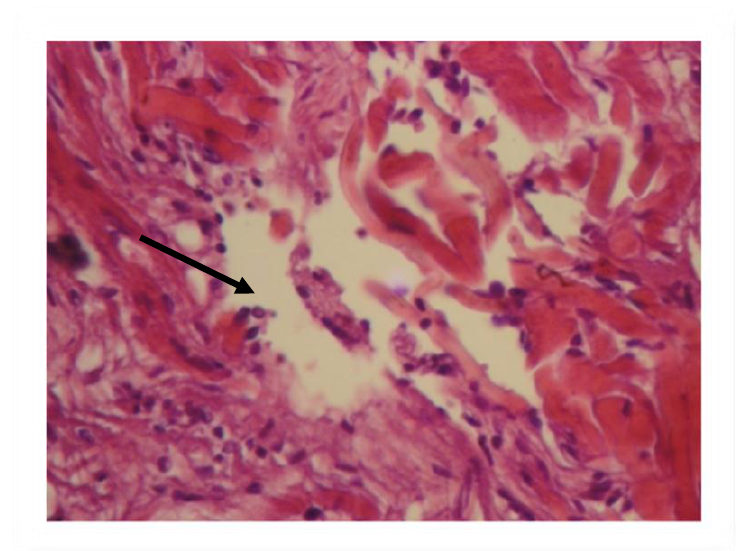
Figure2: Histopathological section of muscle 14day post infection show muscle structure fragmentation with inflammatory odema